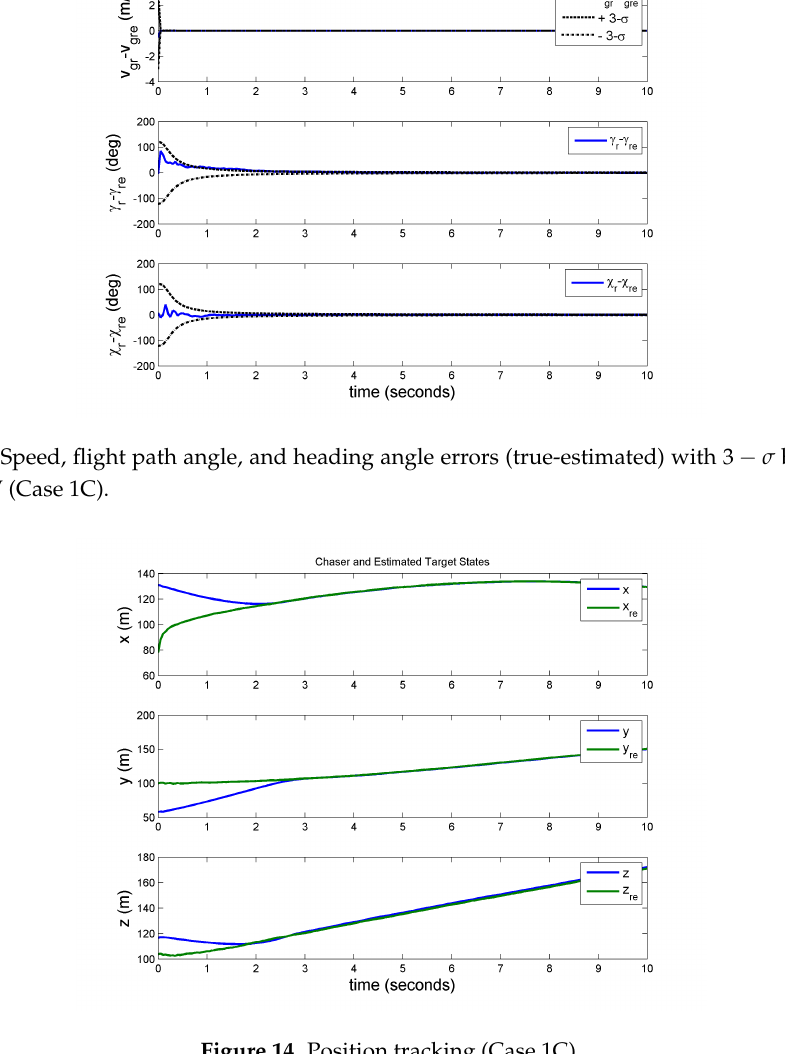
Figure 14. Position tracking (Case